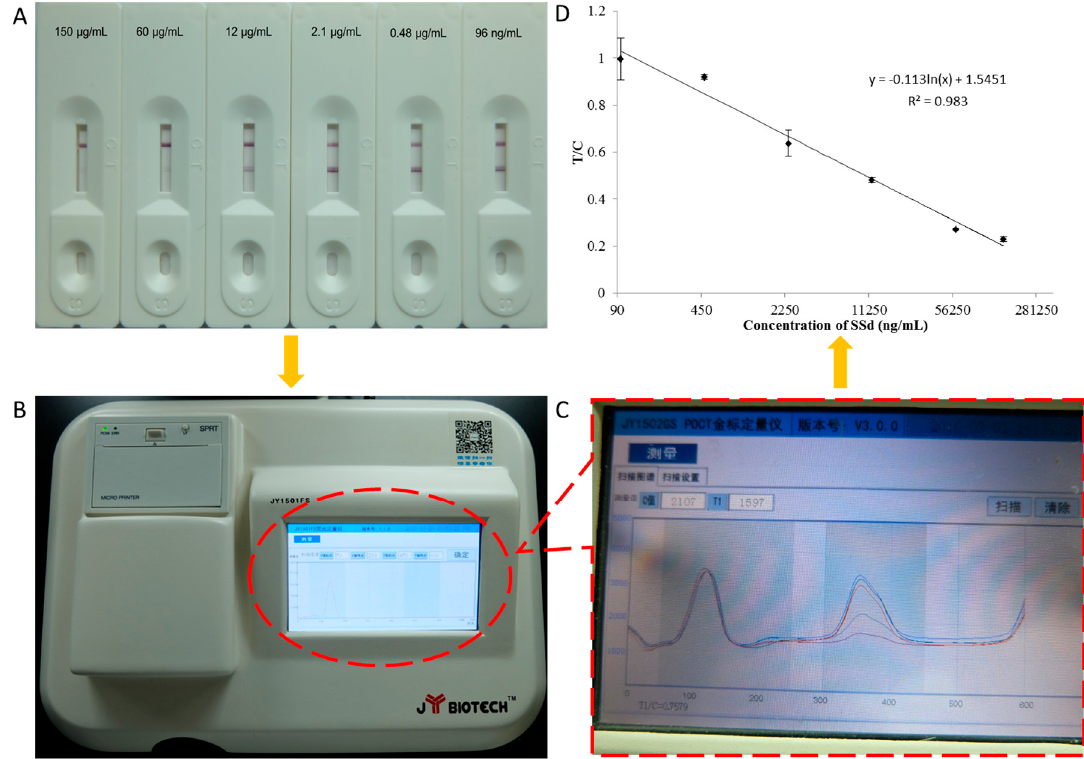
Figure 2. Characterization of the lateral-flow immunoassay for SSd. ( A ) Photographs of results for standard solutions containing different concentrations of SSd assayed using the ICS; ( B ) Photograph of the matched colloidal gold scanned; ( C ) The intensity pattern of the test and control lines scanned by the colloidal gold quantitative instrument; ( D ) Standard curve of icELISA for SSd determination using the ICS. The regression equation is y = − 0.113ln( x ) + 1.5451, with a correlation coefficient ( R 2 ) of 0.983.